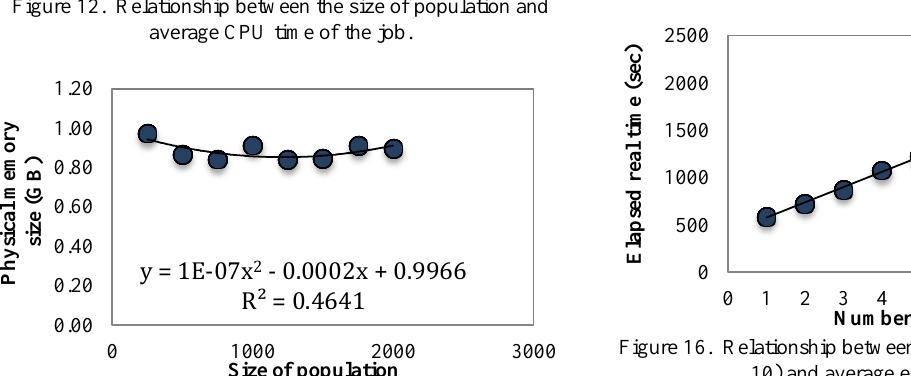
Figure 15. Number of generations versus average elapsed real time.